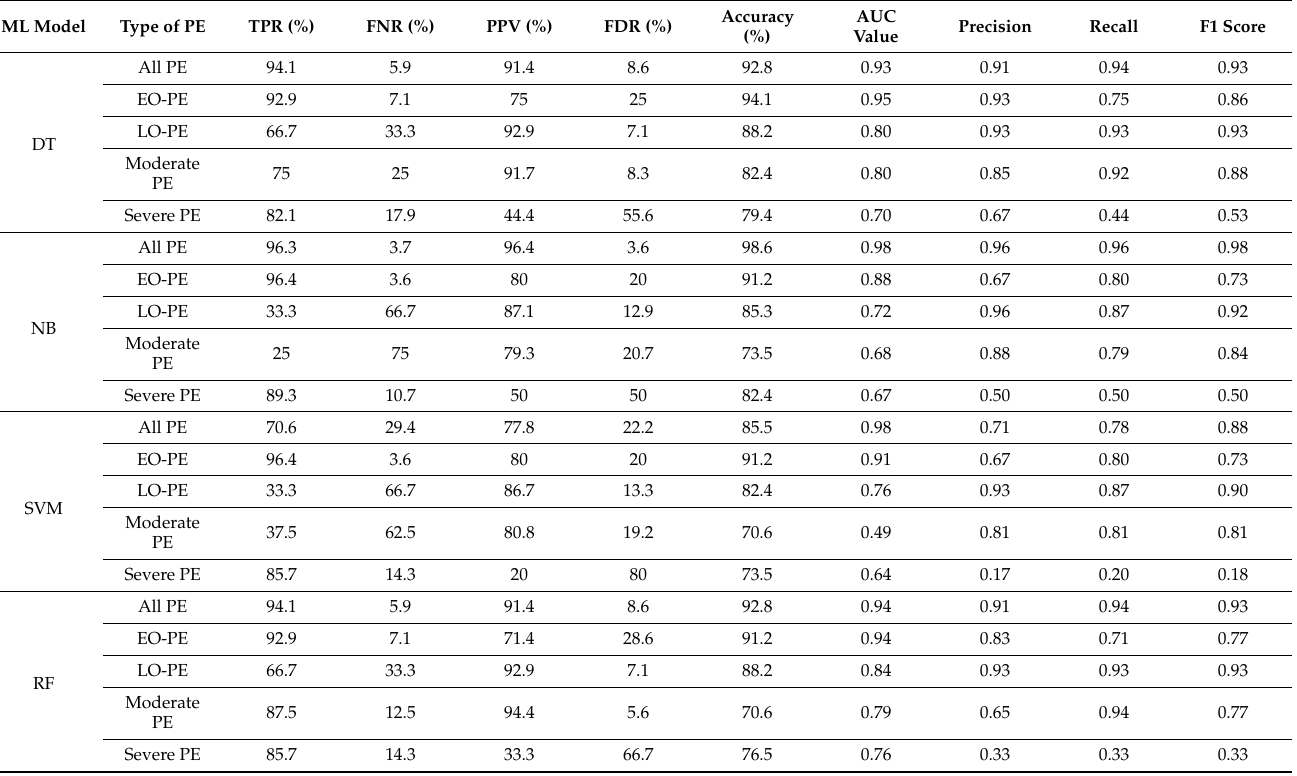
Table 4 legend: All PE—all types of preeclampsia; EO-PE—early- onset preeclampsia; LO-PE—late-onset preeclampsia; ML—machine learning; DT—decision trees; NB—naïve Bayes; SVM—support vector machine; RF—